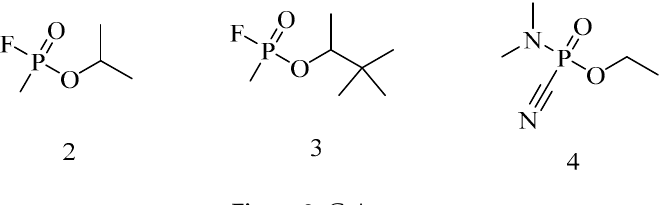
Figure 2. G-Agents. Figure 2. G-Agents.